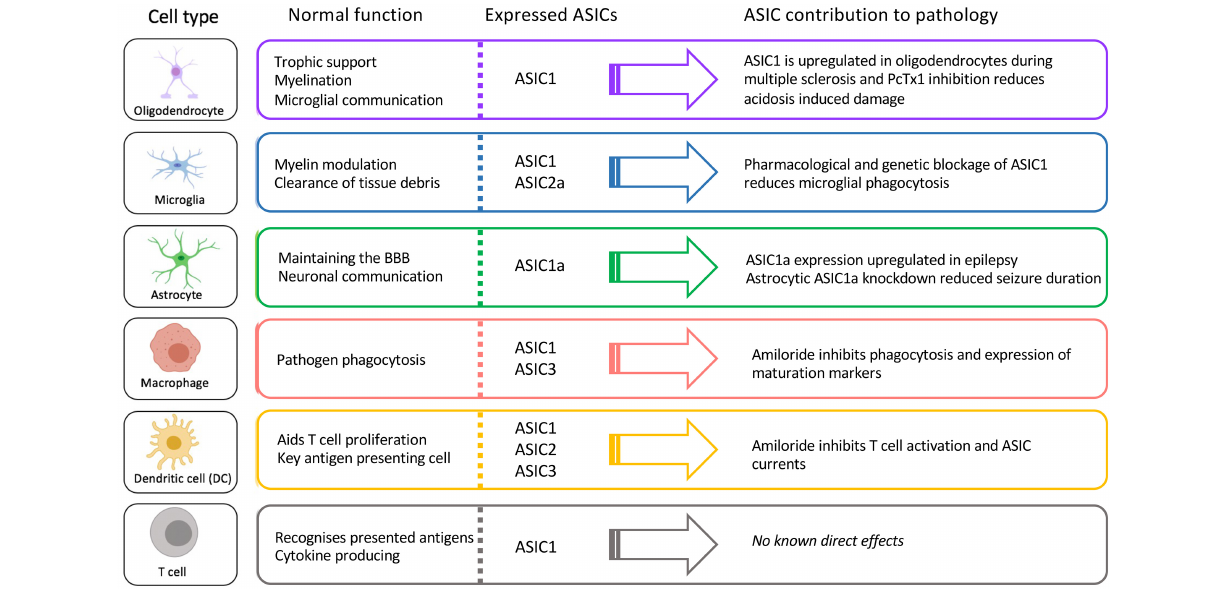
FIGURE 5 | Function, ASIC profile, and putative role of ASICs in CNS immune